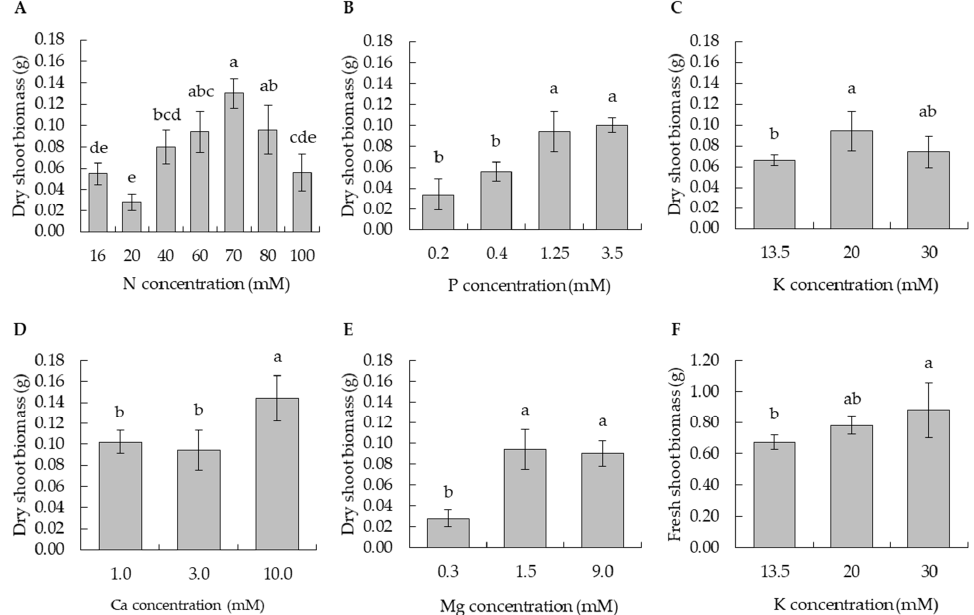
Figure 1. Effect of varying nutrient supplies in MS media on potato plant dry shoot biomass weight: ( A ) nitrogen: N; ( B ) phosphorus: P; ( C ) potassium: K; ( D ) calcium: Ca; ( E ) Magnesium: Mg; and ( F ) K effect on fresh shoot biomass weight. Error bars on bar graphs represent standard deviations. Means separated according to Tukey’s HSD at p < 0.05, and bars with same lowercase letters are not statistically different.